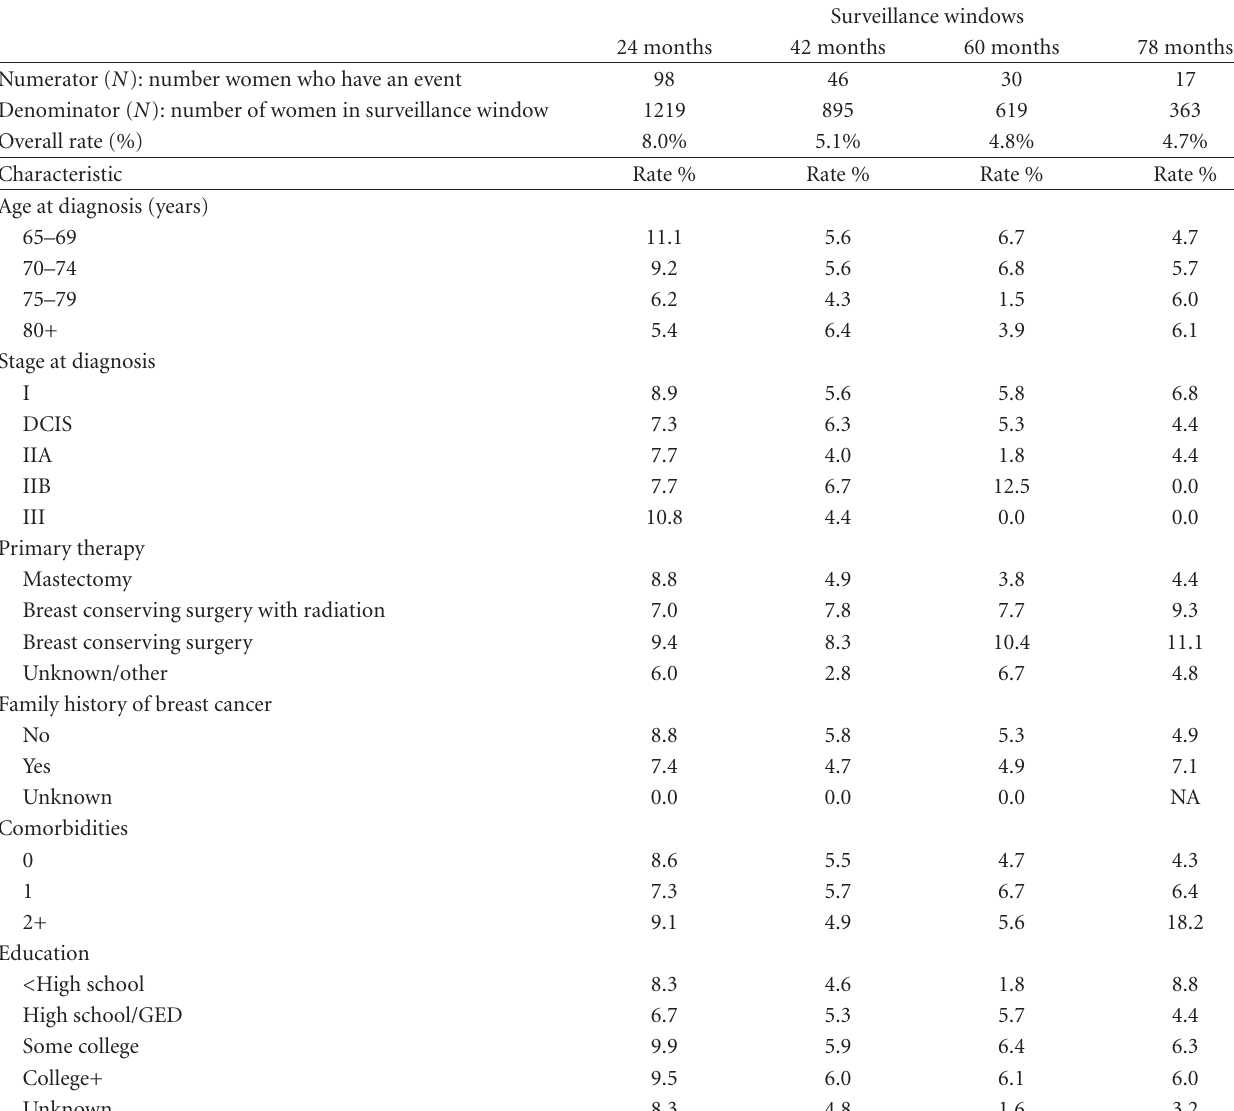
Table 3: Women’s characteristics and ultrasound/MRI rates for each surveillance window.